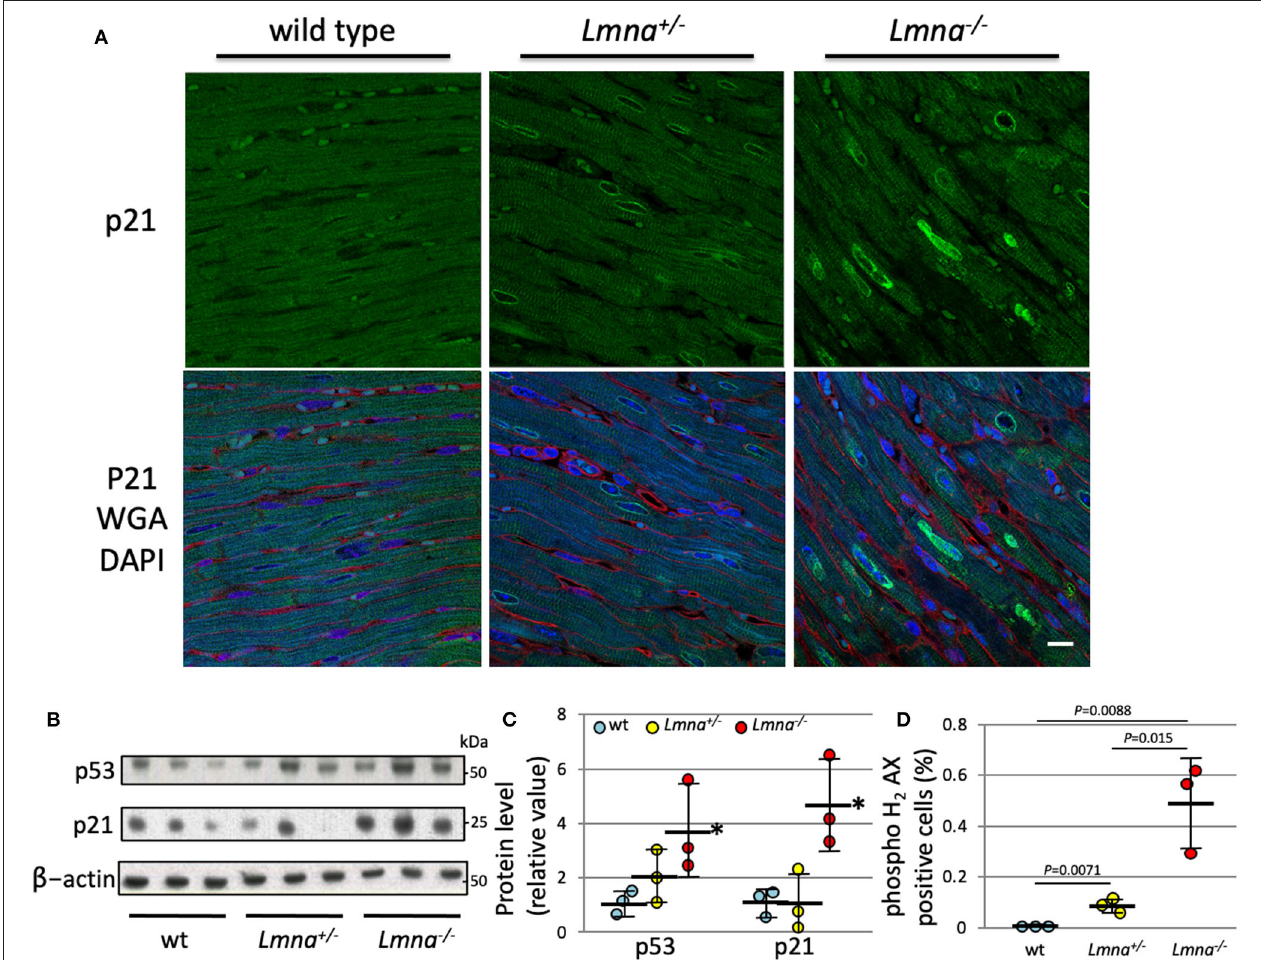
FIGURE 4 | Protein expression of p21 and p53, and DNA damage of cardiomyocyte in 5 weeks. (A) Immunostaining against anti-p21 antibody in heart tissue section of wt, Lmna + / − , and Lmna − / − . The top panel shows p21 staining, and the bottom panel shows merged figures of anti-p21 antibody (green), WGA (red), and DAPI (blue). Scale bar: 10 µ m. (B) Western blot analysis of LV tissue hybridized with p53, p21, and β -actin Abs. The data shown are representative of three independent experiments. (C) Protein expression level of p53 and p21 normalized by β -actin. * P < 0.05 vs. respective wt. (D) Percentage of phospho histone H 2 AX staining counted in cardiomyocytes ( Supplementary Figure 2 ) ( n = 3 in each group). Dots represent individual mouse data. The significance of differences between 3 groups was determined with 1-way ANOVA. Post-hoc pairwise comparisons were performed with the Tukey–Kramer